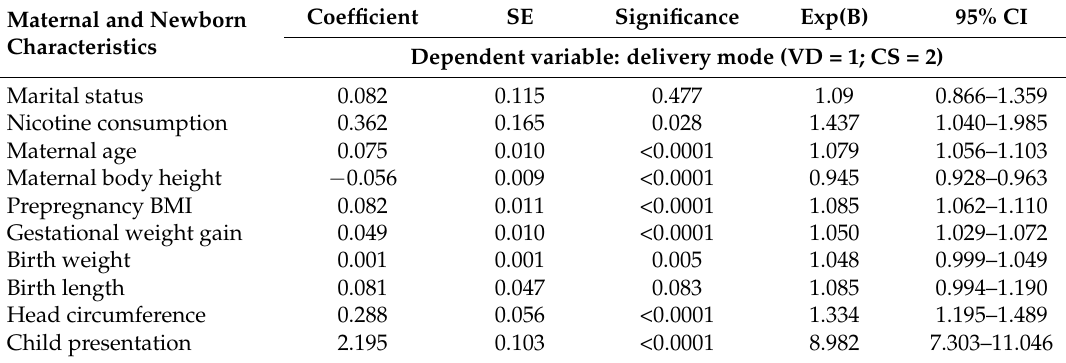
Table 6. Maternal and newborn characteristics and delivery mode. Vaginal delivery versus caesarean section. Binary logistic regression